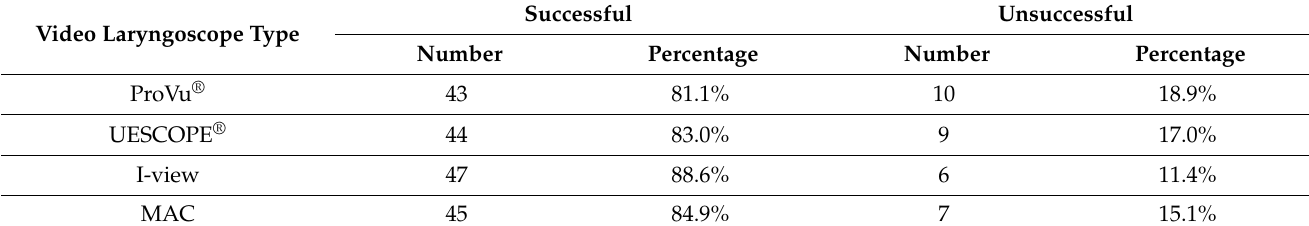
Table 2. Number of successful and unsuccessful intubation attempts with each video laryngoscope.